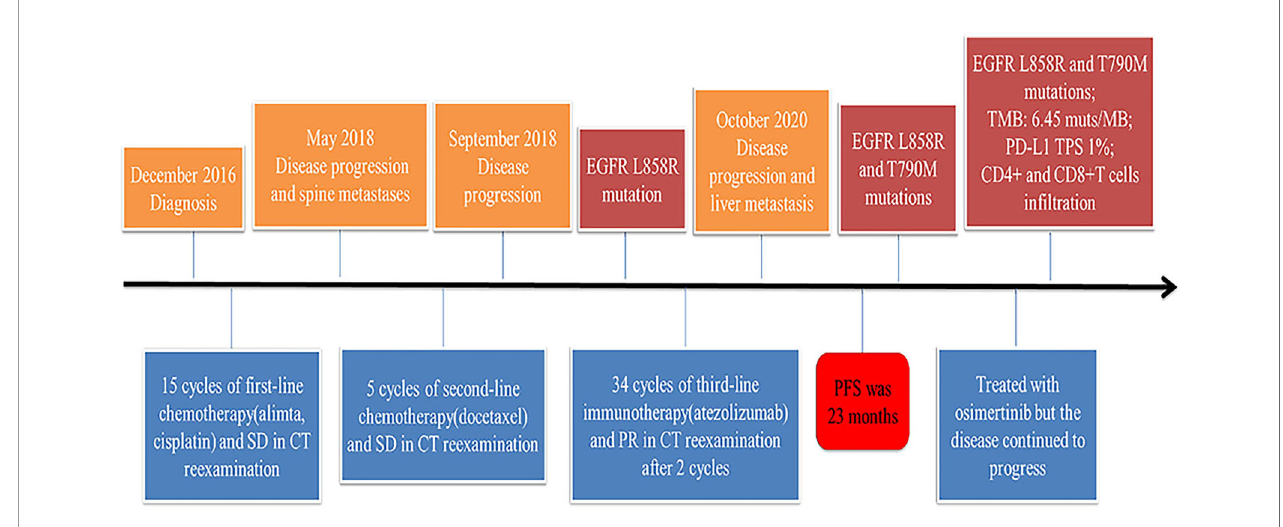
FIGURE 1 | Timeline of disease status and corresponding treatment